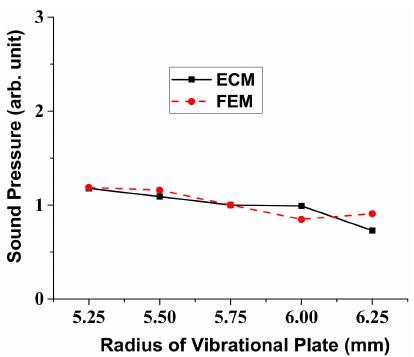
Figure 7. Effect of the vibrational plate radius variation on the radiated sound pressure.